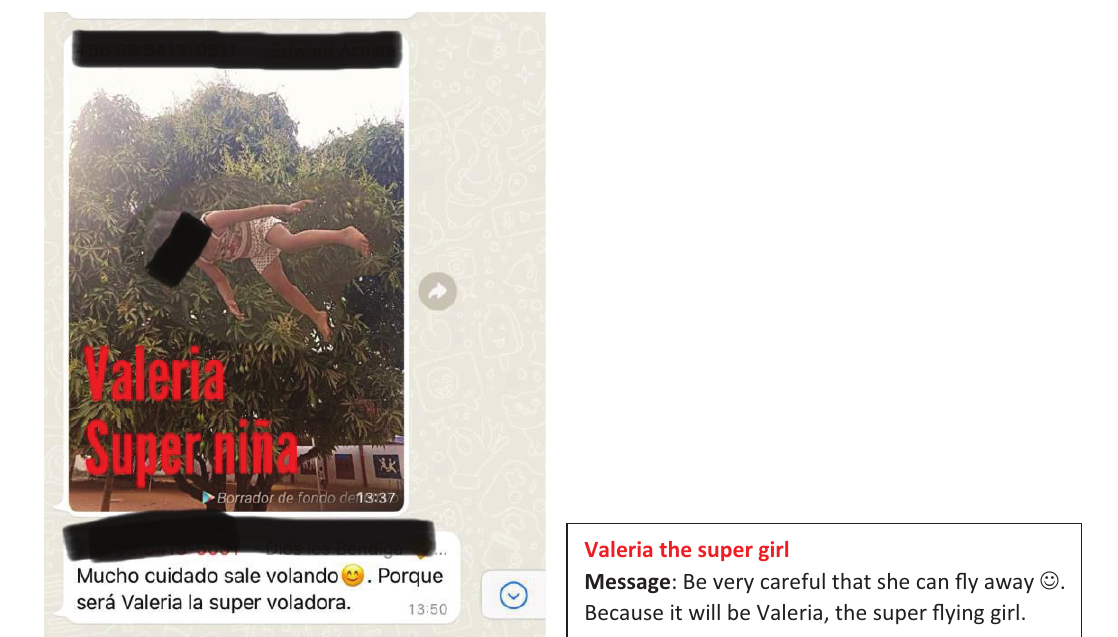
Figure 2. Snapshot from the communication on WhatsApp showing the humorous material produced by Mr. Edward.